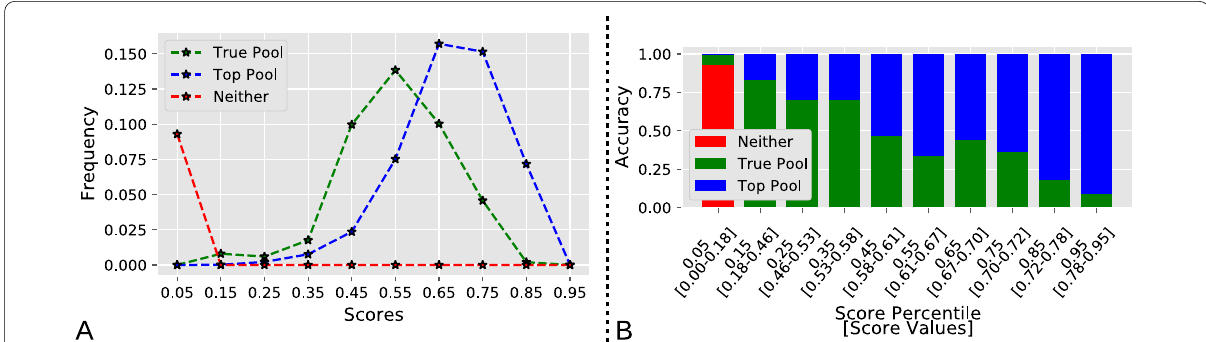
Fig. 5 A Frequency of term scores for terms in the Top Pool, True Pool, and in neither (missed labels). B Accuracy as a function of term score and corresponding term score percentile